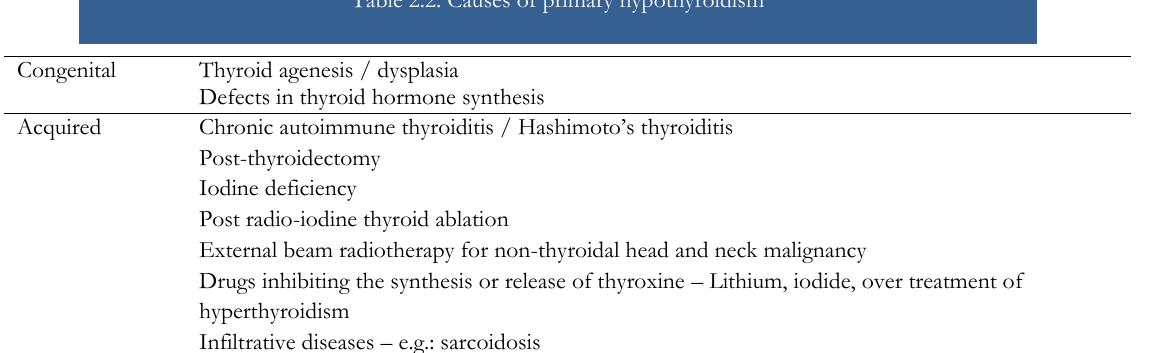
Table 2.2. Causes of primary hypothyroidism